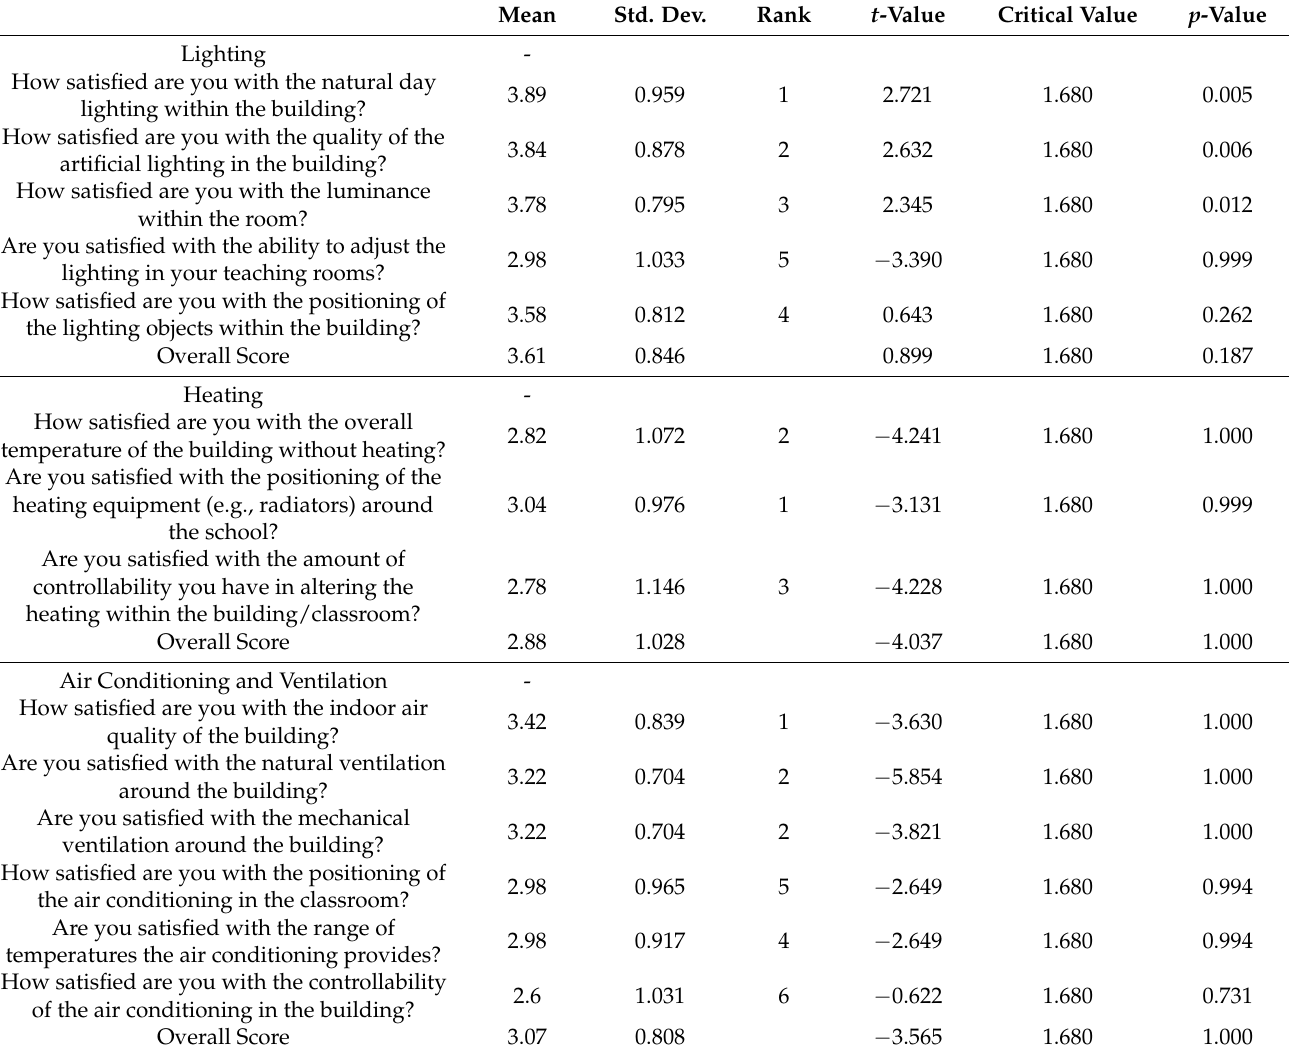
Table 4. Mean (SD), mean rank, and test statistics ( t -value = 3.5). Mean Std. Dev. Rank t -Value Critical Value p